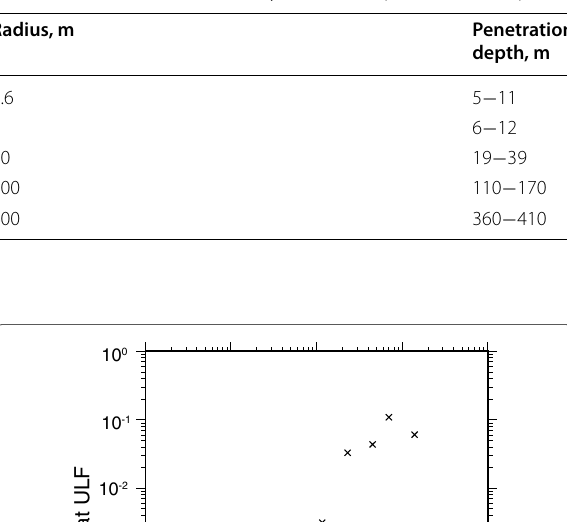
Table 1 Relation between array radius and penetration depth